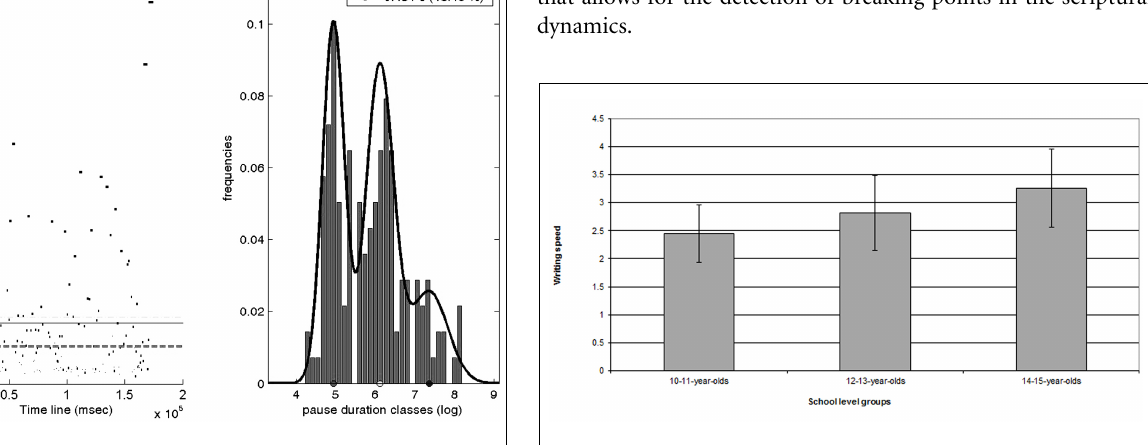
FIGURE 2 | Pause distribution and Gaussian mixture estimated for the pauses of an expository draft text of a 10–11-year-old subject.